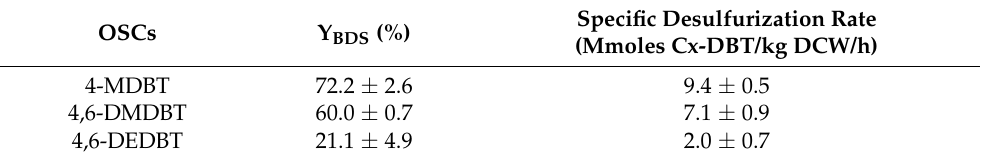
Table 2. Υ BDS and specific desulfurization rates of 4-MDBT, 4,6-DMDBT, and 4,6-DEDBT